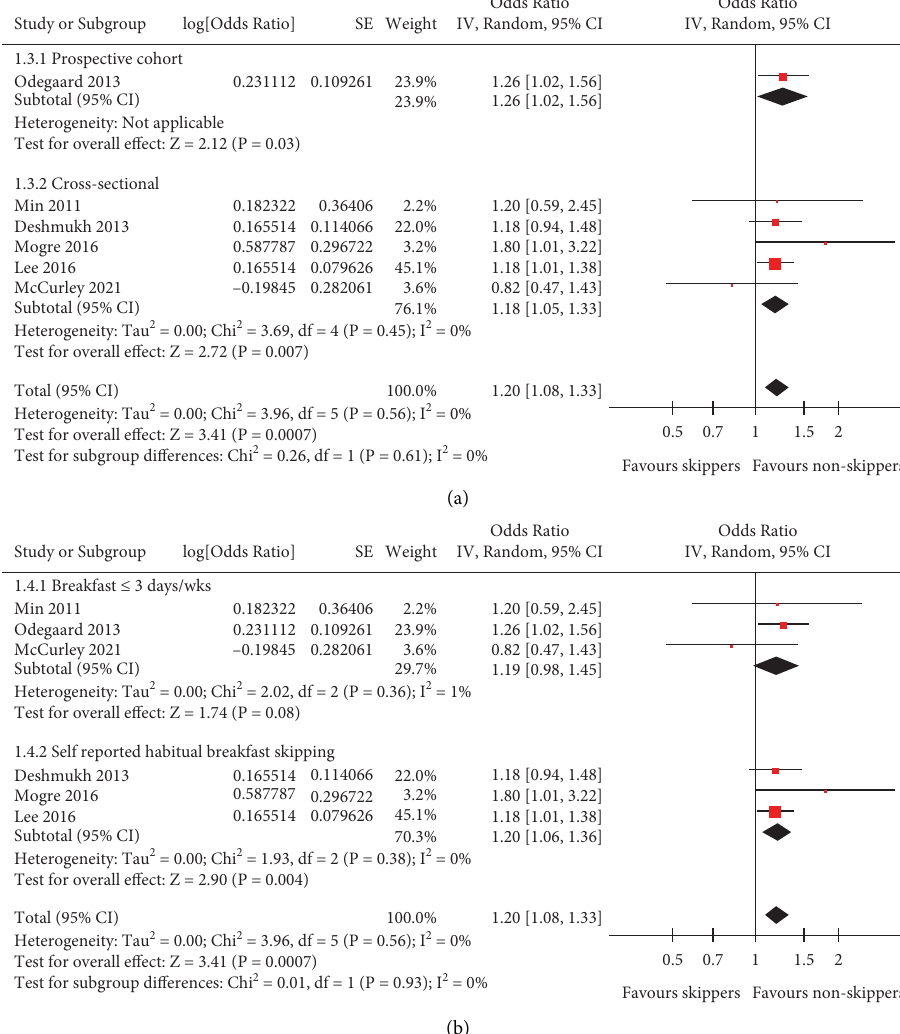
Figure 3: Forest plots for the subgroup analyses of the association between skipping breakfast and hypertension in the adult population. (a) Subgroup analysis according to study design. (b) Subgroup analysis according to the definition of skipping